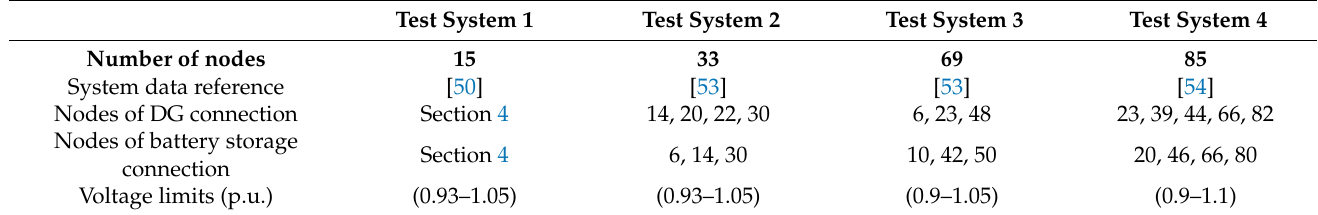
Table 7. Summary of the